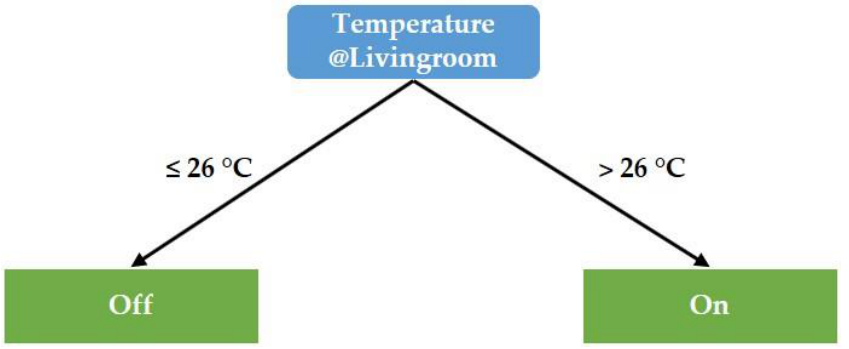
Figure 8. Resulting decision tree for living room air conditioner.